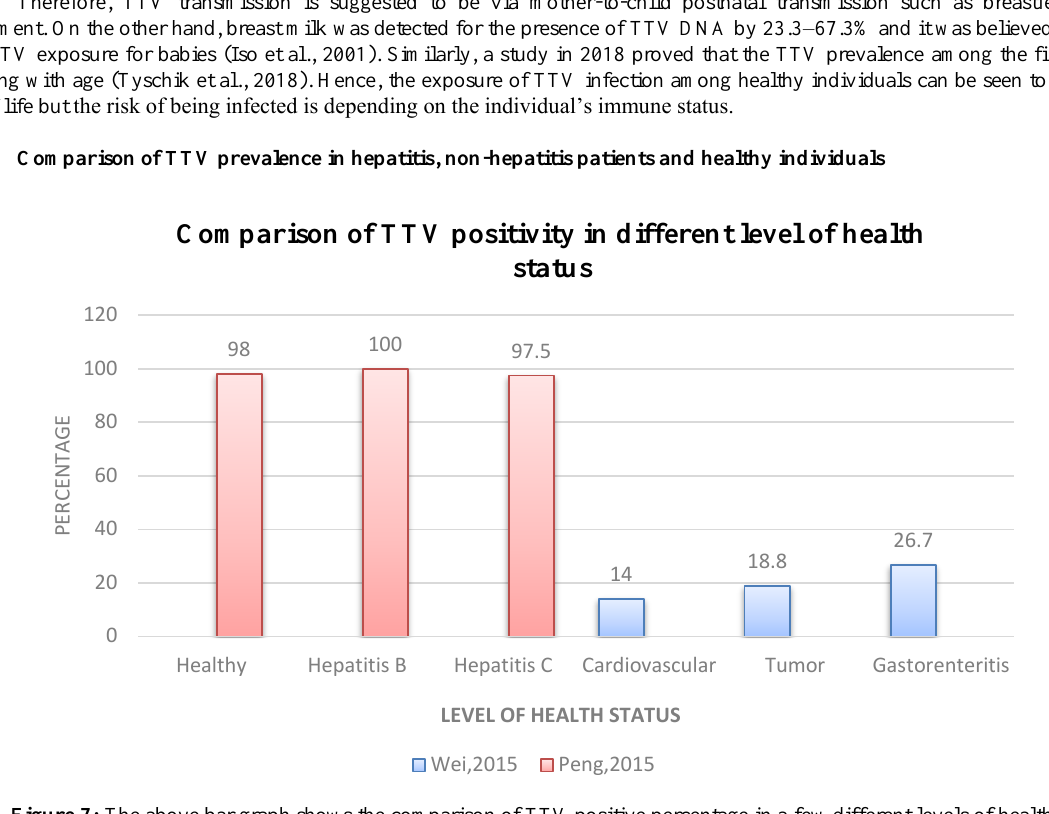
Figure 7: The above bar graph shows the comparison of TTV positive percentage in a few different levels of health